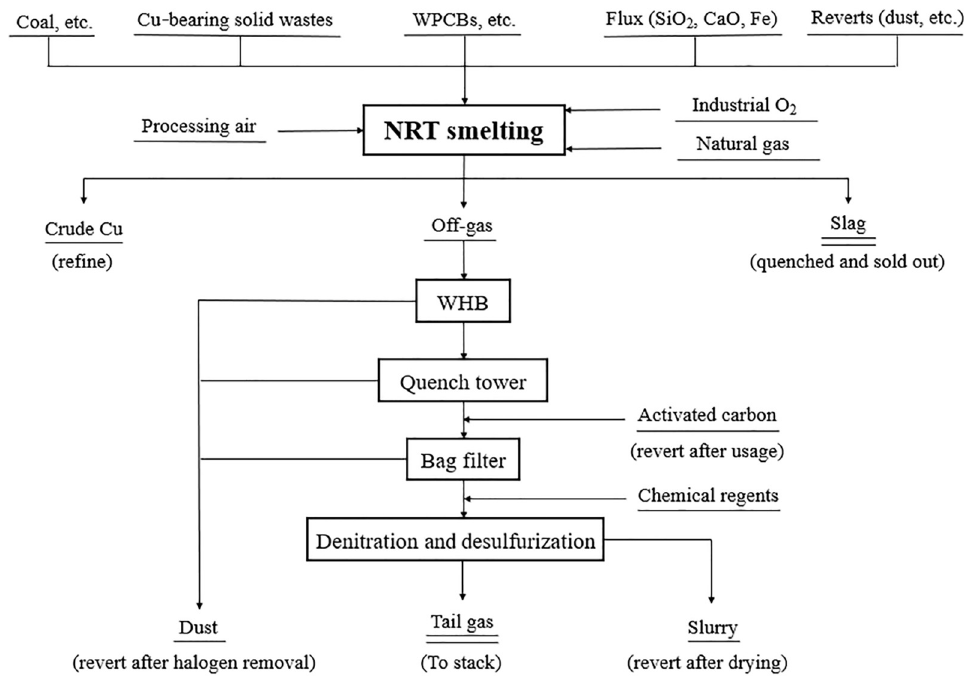
Figure 1. The flowsheet of E-waste processing with the NRT technology. WHB: waste heat boiler.